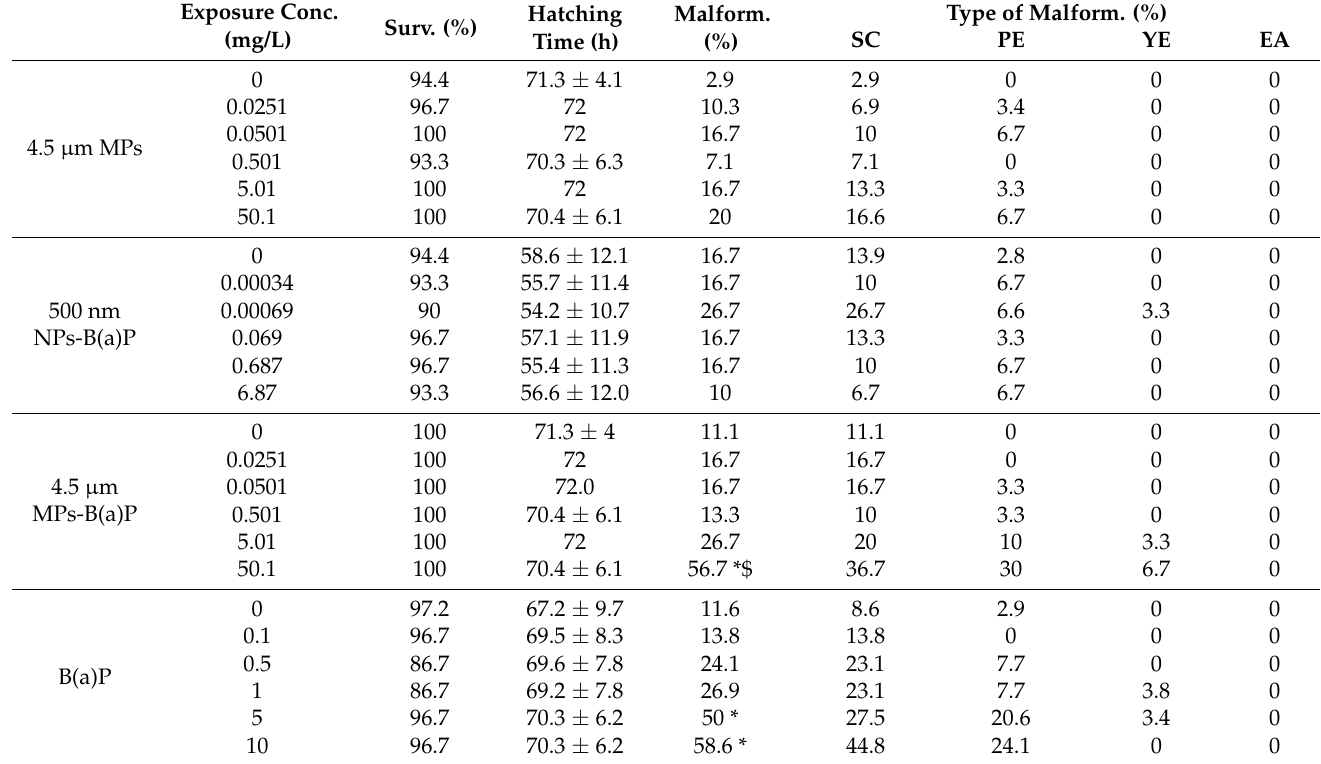
Conc. = concentration; EA: eye abnormality; Malform. = malformation; PE = pericardial edema; SC = spinalcord flexure; Surv. = survival; YE = yolk sac edema. Asterisks (*) indicate statistically significant differences ( p < 0.05) compared to the control group according to the binomial logistic regression. Dollars ($) indicate statistically significant differences ( p < 0.05) compared to the exposure to NPs and MPs of the same size without B(a)P at the same exposure concentration. The values of the corresponding odd ratios and confidence intervals are given in Table